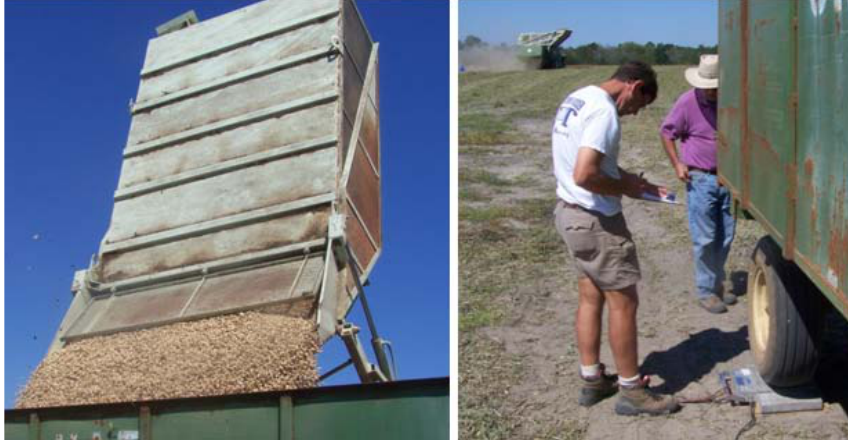
Figure 5. Peanut harvester emptying a load of peanuts into a peanut wagon (left) and load scales used to record weight of peanuts harvested from a pass (right). A load scale is located under each wheel of the